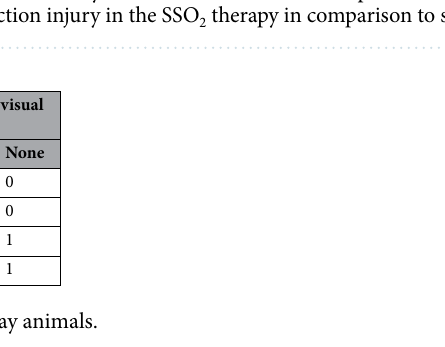
Figure 4. Key myocardial morphometric indices at 30 days. Note the trend toward less prominent histomorphometric indices of myocardial infarction injury in the SSO 2 therapy in comparison to sham.